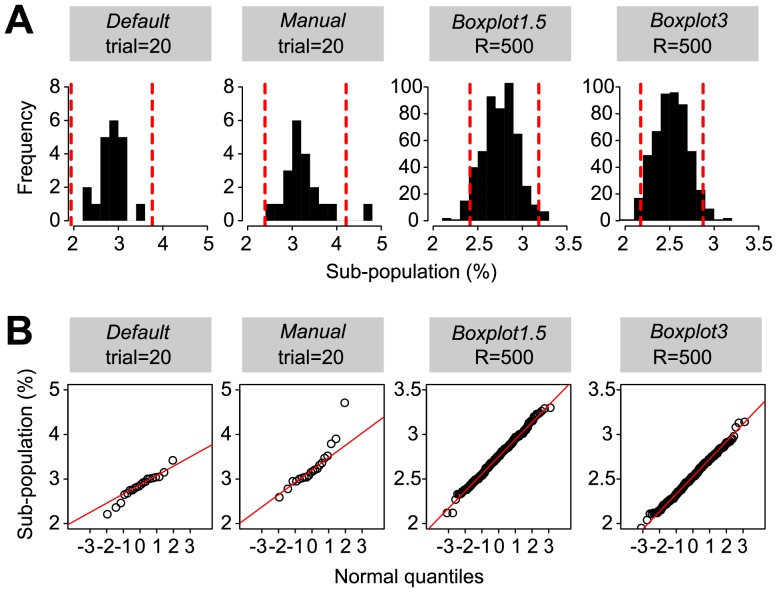
Effect of re-sampling methods of original data sets on the determination of confidence intervals for the subpopulation size of egfp-expressing cells in stationary phase cultures of P. knackmussii B13 strain 2399 (single copy PinR
-egfp) grown on 3CBA.(A) Bootstrapping of original data sets (re-sampling with replacement). Methods Default and Manual were repeated 20 times with manual intervention of the slope line determination. Methods Boxplot1.5 and Boxplot3 use 500 automatically re-sampled data sets. 95% confidence intervals (red, dotted lines) were calculated assuming a normal distribution of the results (mean±SD×1.96). (B) same data as in (A) but re-sampled subpopulation size determinations plotted as Q-Q plots. Note the normal distribution of the results.